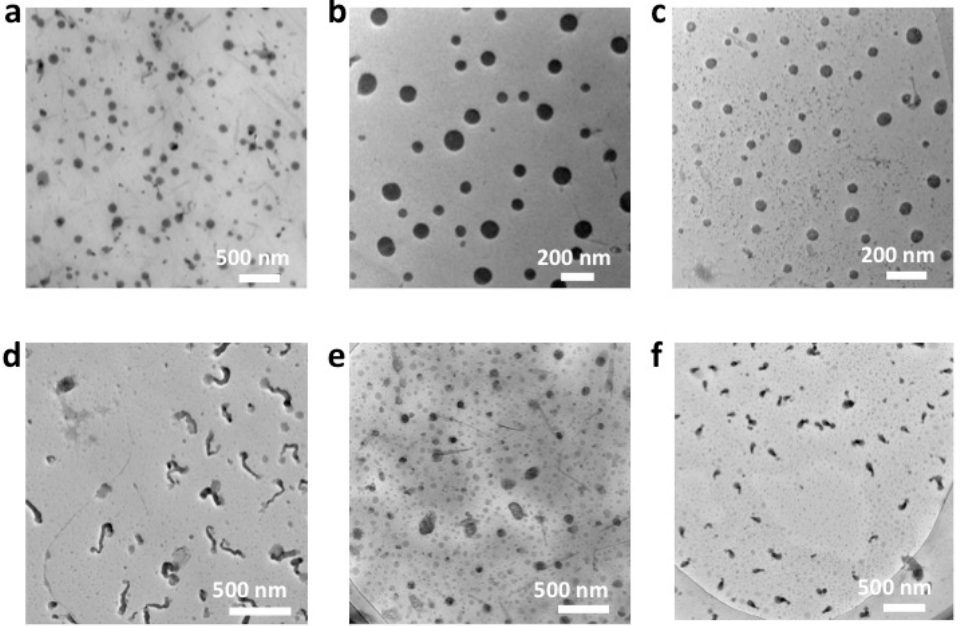
Figure 1. Representative transmission electron microscope (TEM) images of ( a ) RPO-1 prepared by